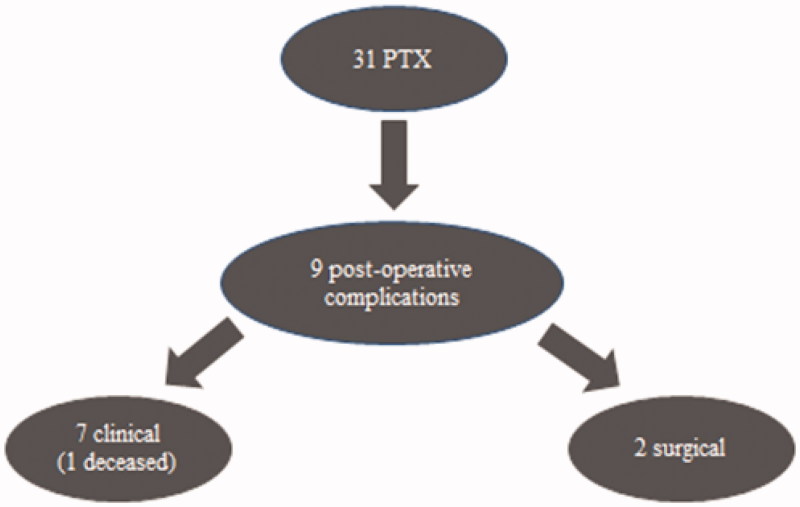
Surgical morbidity.